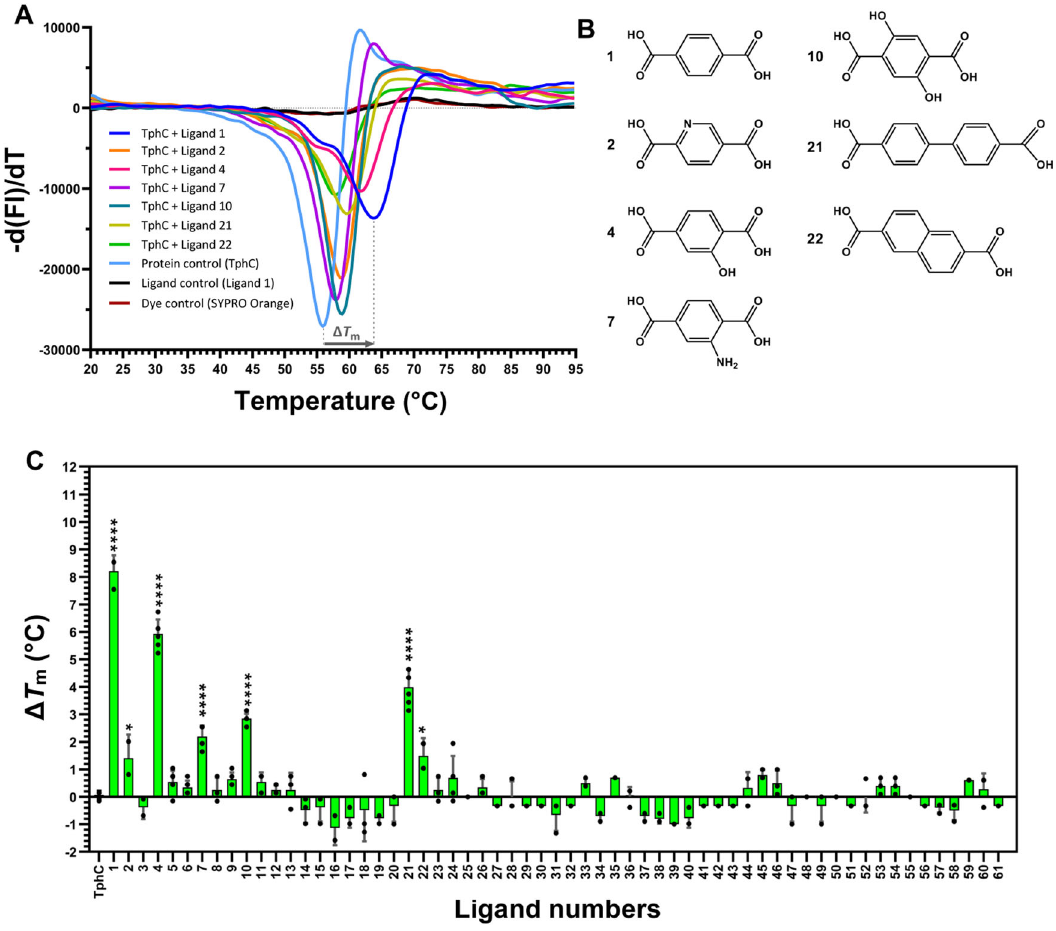
Fig. 2 TphC unfolding pro fi le and melting temperature determination. A The presence of different ligand induced shifts of the TphC melting curve (light blue) to the right (mauve to dark blue melting curves) resulting in a maximum stabilisation of ~8 °C. The fi rst derivative of melting curves enables the determination of melting temperature T m (in fl ection point in the raw fl uorescence traces, see Supplementary Fig. 2. FI fl uorescence intensity). B Chemical structures of the ligands producing a thermal shift terephthalate ( 1 ), 2,5-pyridinedicarboxylate ( 2 ), 2-hydroxyterephthalate ( 4 ), 2-aminoterephthalate ( 7 ), 2,5-dihydroxyterephthalate ( 10 ), bipheny-4,4 ′ -dicarboxylate ( 21 ) and 2,6-naphthalenedicarboxylate ( 22 ). C The degree of protein stabilisation in the presence of various ligands was calculated as Δ T m . The data shown are the mean of independent experiments ( n = 3) and the error bars show the standard deviation (SD) of the mean. The statistical difference between ligand groups and the ligand-free TphC control was assessed using one-way ANOVA using Dunnetts multiple comparisons tests ( p value < 0.05), where asterisks denote statistically signi fi cant difference (* p < 0.02; **** p < 0.0001) compared to the control. Noted p values 1 <0.0001, 2 0.0184, 4 <0.0001, 7 <0.0001, 10 <0.0001, 21 <0.0001, 22 0.0115. Each well of a 96-well plate contained 50 µ l of total reaction buffer (25 mM Tris-HCl (pH 7.5)/200 mM NaCl), 60 µ M of TphC, 1200 µ M of ligand and 1× SYPRO orange dye, and fl uorescence was monitored at each 1 °C rise in temperature from 20 to 95